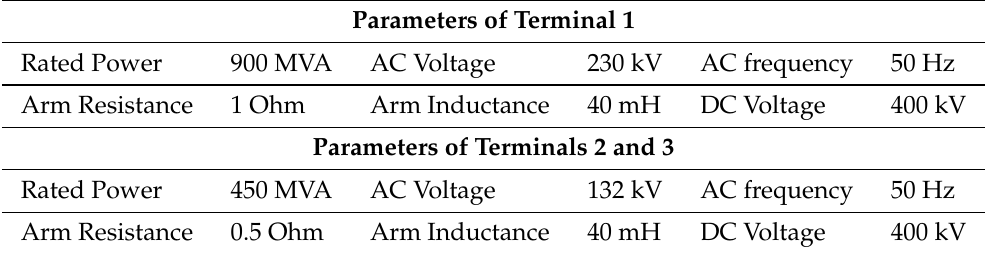
Table 2. Parameters of the simulated MT-HVDC